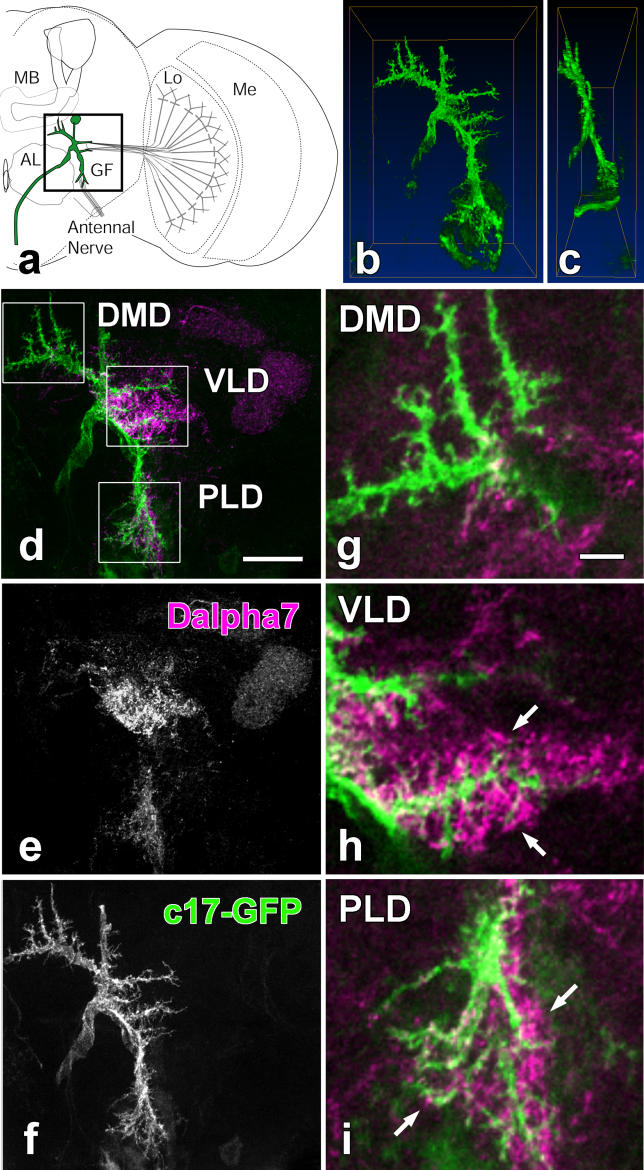
Expression of Dα7 in the Giant Fiber(A) Schematic of theDrosophila brain showing the location of the giant fiber in relation to other brain regions. The inputs to the giant fiber dendrites from the lobula and antennal nerve are also shown. Abbreviations: AL, antennal lobe; GF, giant fiber; Lo, lobula; MB, mushroom body; Me, medulla.(B) Frontal view of the giant fiber dendrites viewed from the posterior.(C) Sagittal view of the giant fiber dendrites showing the anterior-posterior position of the various dendritic branches.(D–F) Colocalization of Dα7 immunostaining in the dendrites of the giant fiber. Projection of the giant fiber dendrite (green) labeled with CD8-GFP driven by the c17 GAL4 driver and Dα7 staining (magenta) onto the same plane is shown in (D). Single channels of antibody staining (E) and GFP (F) are shown. The three major subdivisions of the dendrites are boxed and labeled according to the terminology of Allen et al. 1998 [32]. Abbreviations: DMD, dorsal medial dendrite; VLD, ventral lateral dendrite; PLD, posterior lateral dendrite.(G–I) Magnified views of the three dendritic fields shown in (D). Images of DMD and PLD shown in (G) and (I), respectively, are projections of eight confocal slices for a total of 4 μm thickness. The image of VLD shown in (H) is a single confocal section of 500 nm. Arrows show Dα7 staining decorating giant fiber dendrites. Bounding box in (B) and (C): 140 × 71 × 20 μm. Scale bar: 20 μm (D); 5 μm (G).